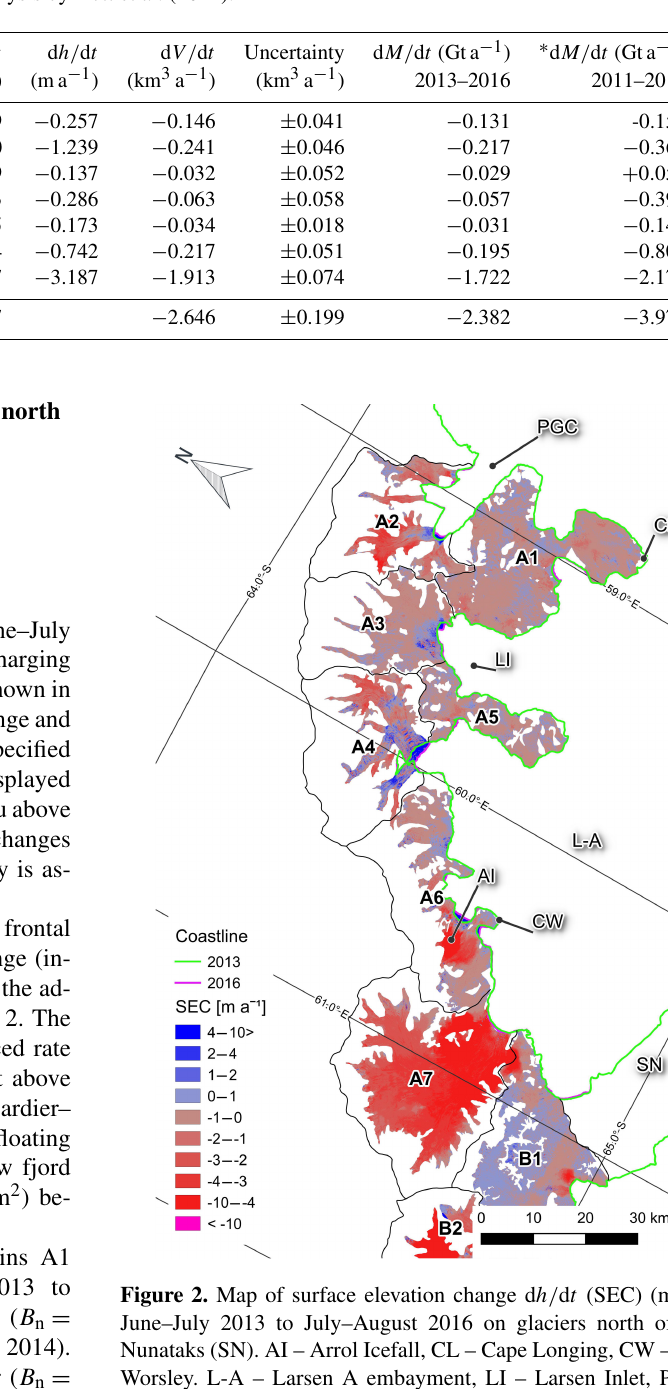
Table 1. Rates of surface elevation change, volume change and mass balance by means of TDM DEM differencing 2013 to 2016, for glacier basins discharging into Prince Gustav Channel, Larsen Inlet and Larsen A embayment. d h/ d t is the mean rate of elevation change in the area covered by the high-resolution map (Fig. 2). The basin area refers to ice front positions delineated in TanDEM-X images of 16 July, 27 July, 18 August 2016. The rates of ice volume change (d V/ d t ) and total mass balance (d M/ d t ) refer to grounded ice. ∗ d M/ d t 2011–2013 for grounded areas of basins A1 to A7 from the TDM SEC analysis by Rott et al. (2014).